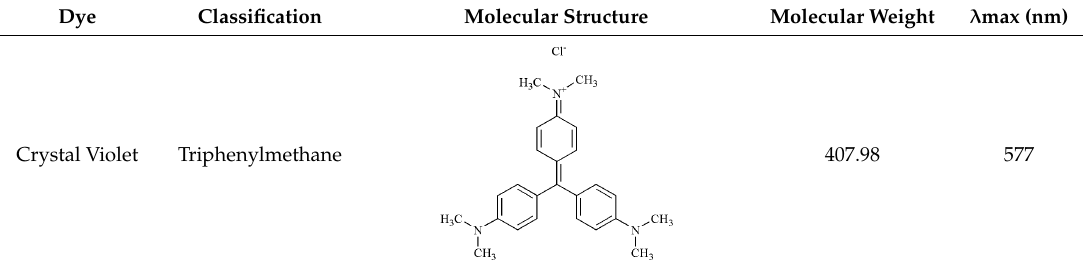
Table 3. Characteristics of dyes used in this study.